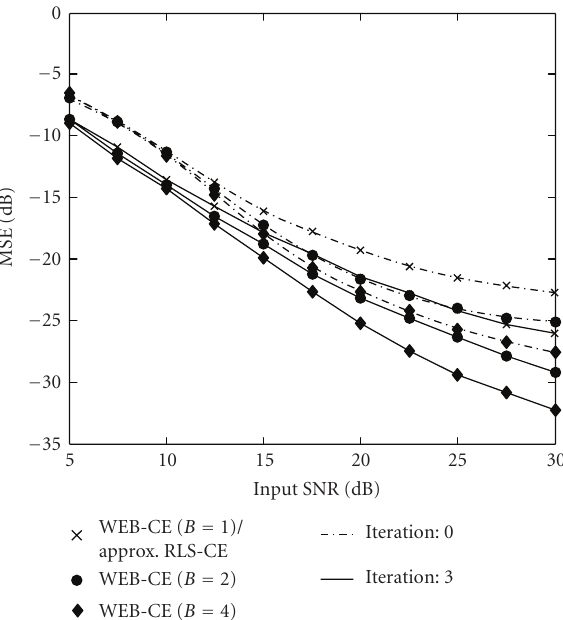
= Figure 5: MSE performance of the WEB-CE ( B = 1)/approx. RLS- w CE, and WEB-CE ( B = 2,4) when f d = 5